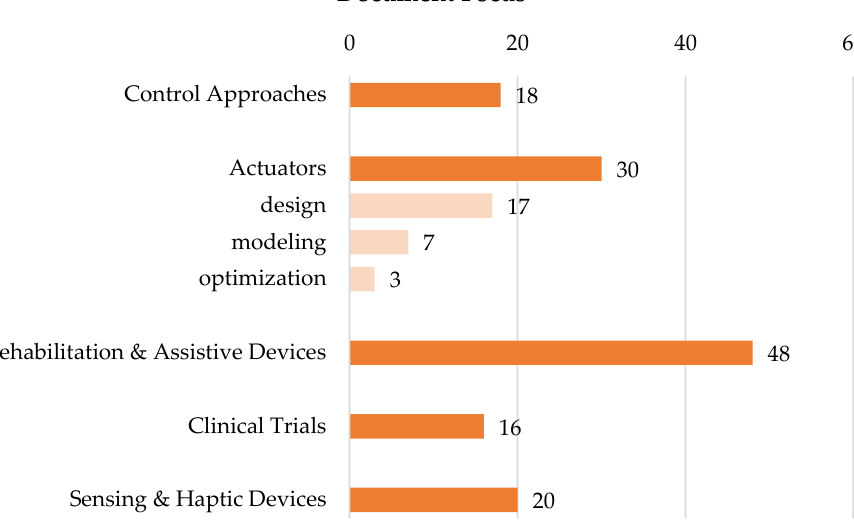
Figure 13. Main focus of the analyzed